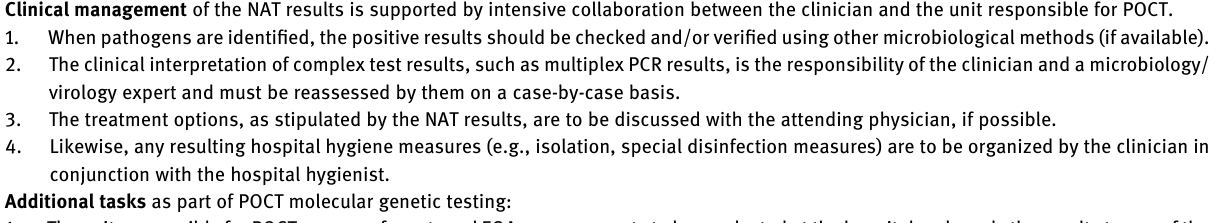
Table  : Clinical management and further tasks of the unit responsible for point-of-care testing (POCT). Clinical management of the NAT results is supported by intensive collaboration between the clinician and the unit responsible for